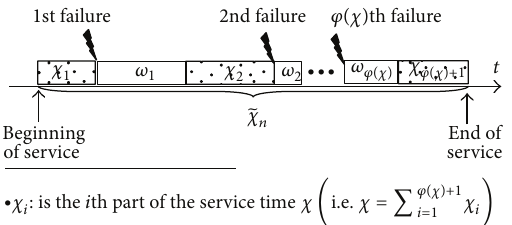
Figure 2: The generalized service time of the 𝑛 th